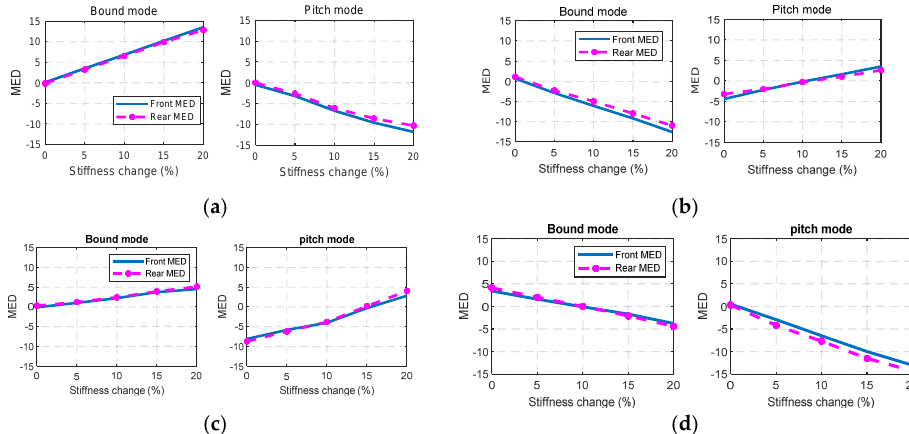
Figure 9. Change of modal energy difference (MED) caused by spring faults at different positions. ( a ): MED changes caused by faults in left front wheel; ( b ): MED changes caused by faults in right front wheel; ( c ): MED changes caused by faults in left rear wheel; ( d ): MED changes caused by faults in right rear wheel.